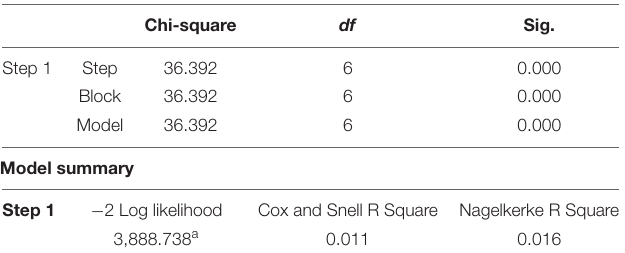
TABLE 5 | Omnibus tests of model coefficients.